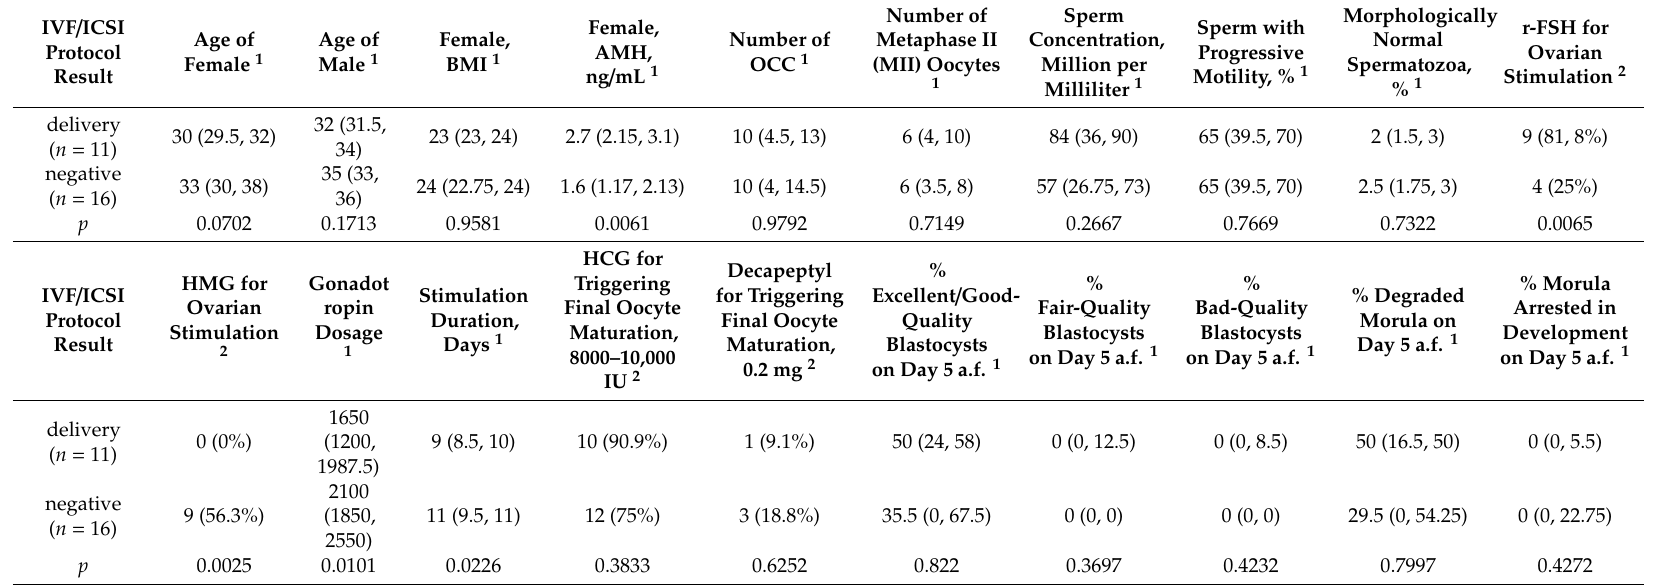
Table 1. Comparative characteristics of clinical data and parameters of the IVF / ICSI protocol in couples depending on the outcome of the ART